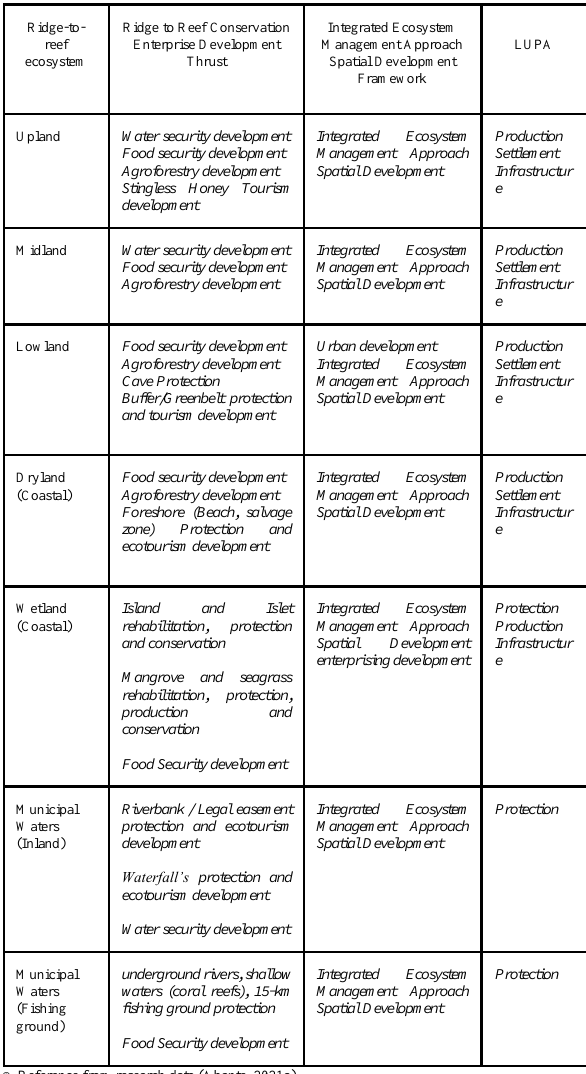
Table 4. Structured plan based on preferred development option and spatial